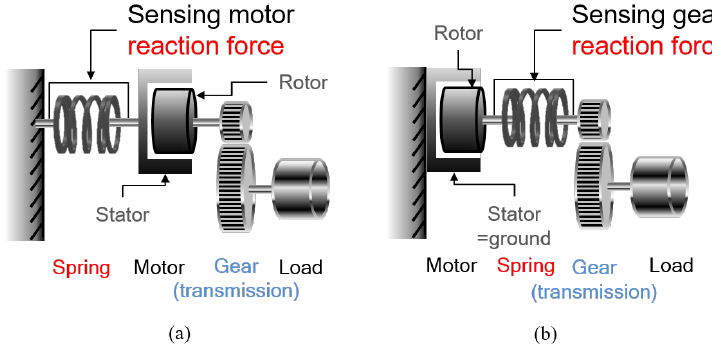
Figure 6. Configurations of Reaction Force-sensing Series Elastic Actuator (RFSEA). ( a ) “motor reaction force” sensing type and ( b ) “gear reaction force” sensing type.